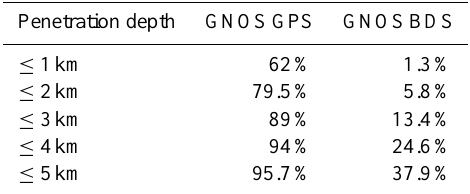
Table 1. Proportion of different penetration depths for GNOS GPS RO and BDS RO from 1 November to 31 December 2013. Penetration depth GNOS